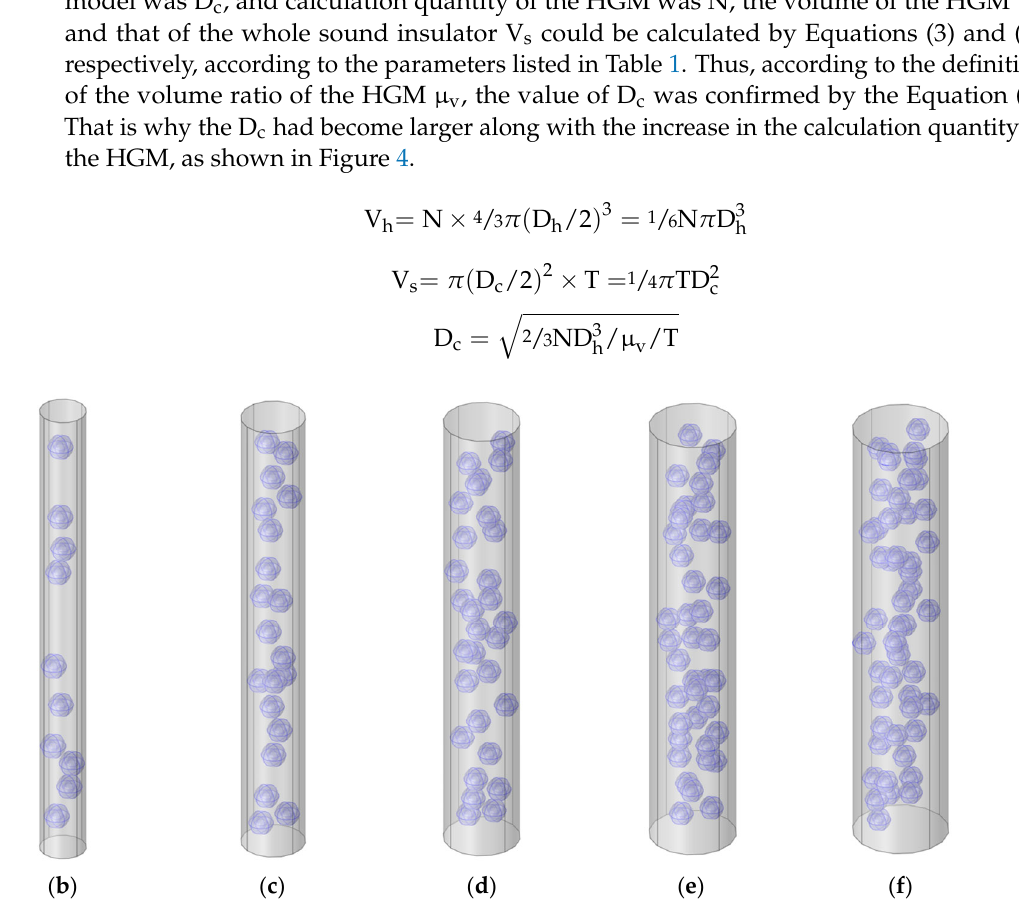
Figure 4. Acoustic finite element simulation models of the composite rubber reinforced with HGM for the various calculation quantity of the HGM. ( a ) 5; ( b ) 10; ( c ) 20; ( d ) 30; ( e ) 40; ( f ) 50. The mesh partition is another pivotal factor influencing the simulation accuracy and efficiency. In order to give consideration to both the simulation efficiency and accuracy, the free tetrahedron mesh grid was utilized, and the minimum cell size was set as D h /20/ µ h, and the maximum cell size was set as D h /2/ µ h for the HGM domain; the minimum cell size was set as D h /20 and the maximum cell size was set as D h for the composite rubber domain; the other domains were generated by sweeping with the distribution number of